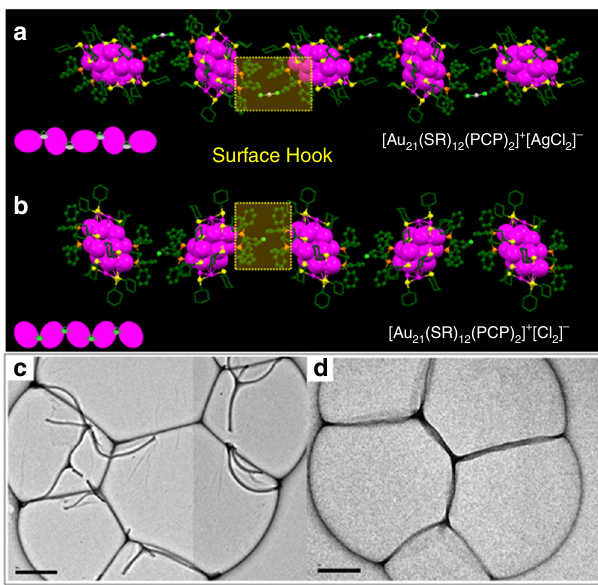
Fig. 4 1D Nano fi brils assembled from the two types of Au 21 NPs. a , b are the packing of [Au 21 (SR) 12 (PCP) 2 ] + [AgCl 2 ] − and [Au 21 (SR) 12 (PCP) 2 ] + [Cl] − in their 1D assemblies. The orientation of Au NPs is modulated by the counterion. Magenta = Au, gray = Ag, light green = Cl, yellow = S, orange = P, green = C. All H atoms are omitted for clarity. Yellow areas are the surface hooks connecting neighboring NPs. c , d display the TEM images of the 1D self-assembly of [Au 21 (SR) 12 (PCP) 2 ] + [AgCl 2 ] − and [Au 21 (SR) 12 (PCP) 2 ] + [Cl] − , respectively, scale bar: 200